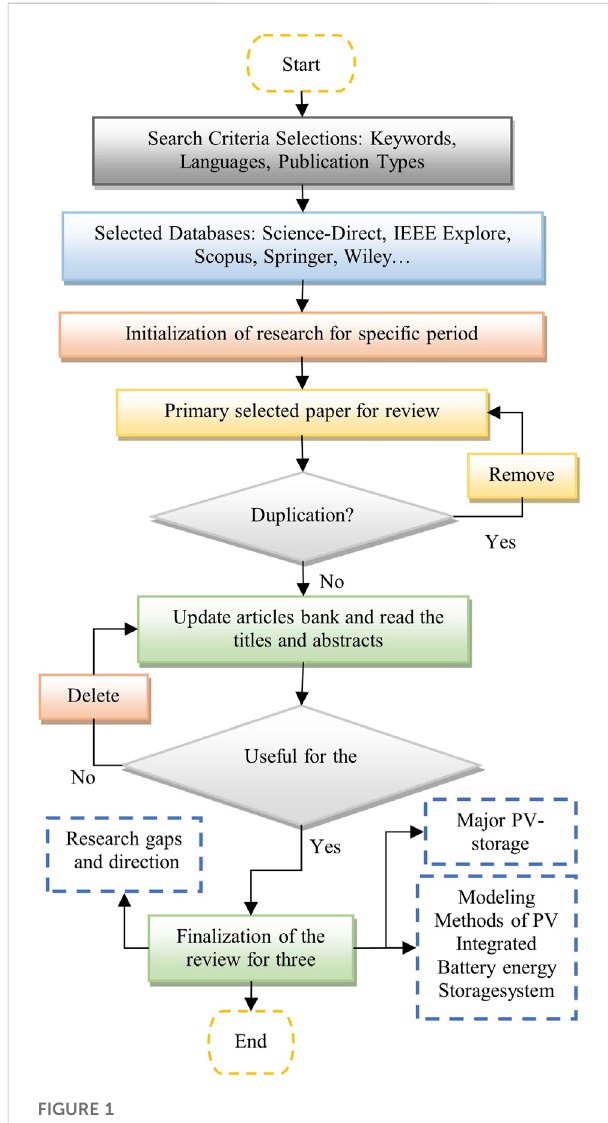
FIGURE 1 Methodology fl owchart for reviewing